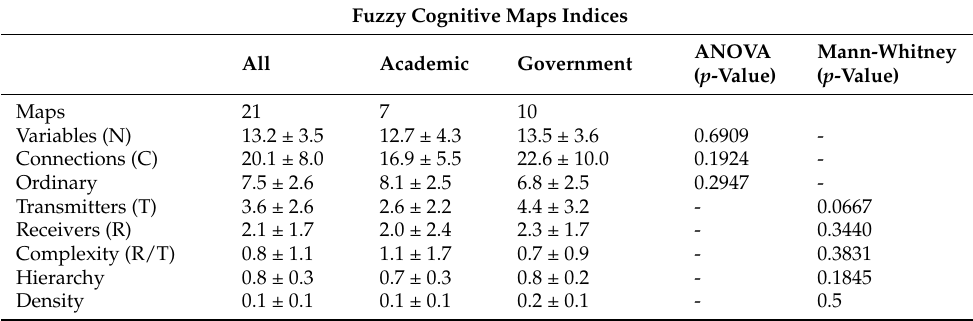
Table 1. The 21 individual stakeholder fuzzy cognitive map structures were compared using graph indices. The FCMs were filtered into academic and government stakeholder groups for comparison. Stakeholder groups’ FCM indices were compared using standard statistical tests such as ANOVA or Mann–Whitney. No statistically significant differences ( p ≤ 0.05) were found after comparing FCM indices from academic and government stakeholder groups (value ± SD) .